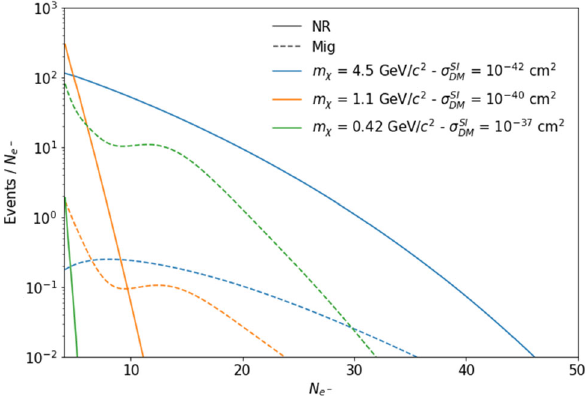
Fig. 4 Signal events in the N e − = [4 , 50] range assuming the DS-50 exposure. The colors represent different DM masses for the NR (solid) and Migdal (dashed) processes